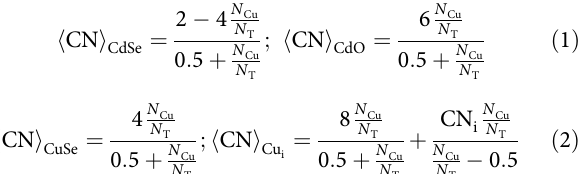
where CN i is the value of the CN for interstitial copper at the critical concentration where ~50% of the CdSe species have converted to Cu 2 Se. The similarity in the behavior of the experimentally and predicted changes in CN with concentration are striking. The theoretically expected crossover point for the (cid:1) 0 : 2 while the crossover point CdSe/CdO species occurs at N Cu N T